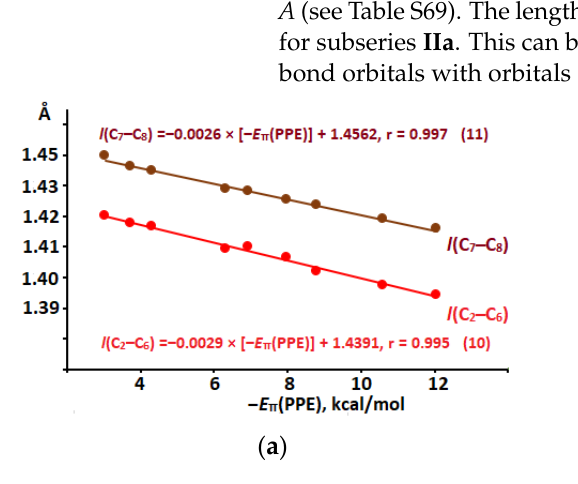
Figure 9. Dependencies of the l (C 2 ‒ C 6 ) and l (C 7 ‒ C 8 ) bond length on − E π (PPE) ( a ) and l (C 6 =C 7 ) and l (C 8 =O 9 ) bond length on − E π (PPE) ( b ) for subseries Ia and b of the studied compounds.